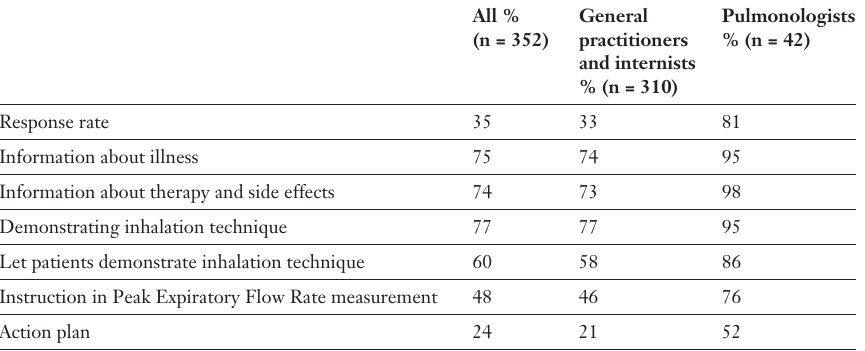
Different aspects patients are offered in asthma education by 310 general phy- sicians (general practitioners and internists) and 42